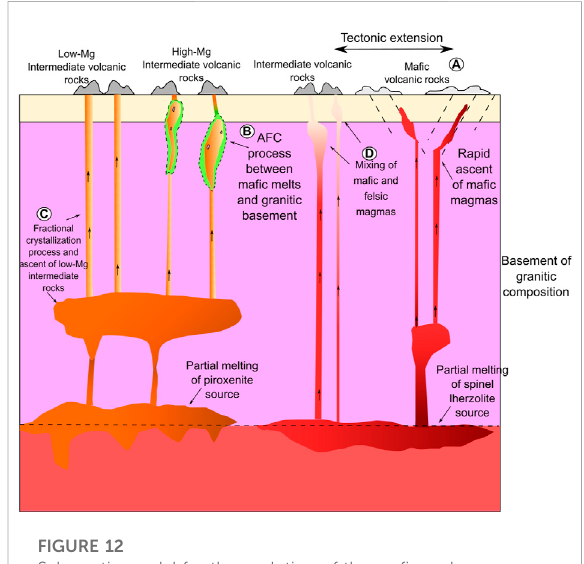
FIGURE 12 Schematic model for the evolution of the ma fi c and intermediate magmas from the MGVF. (A) Ma fi c rocks were generatedthroughpartialmeltingoflherzolite sourcesanddisplay a rapid ascent from the asthenosphere to the surface, which is related to local extensional stresses. (B) Assimilation and fractionalcrystallization (AFC)processesshowanimportantrolein fi nal composition of high-Mg rocks (green patch). (C) Fractional crystallization and/or partial melting of heterogeneous sources (e.g., piroxenites) that contributed to low – high Mg content before intermediate melts arrived to the upper crust. (D) Mixing of ma fi c and felsic magmas in shallow levels of the continental crust; felsic magmas were produced by partial melting of the local basement (modi fi ed from Sosa-Ceballos et al.,